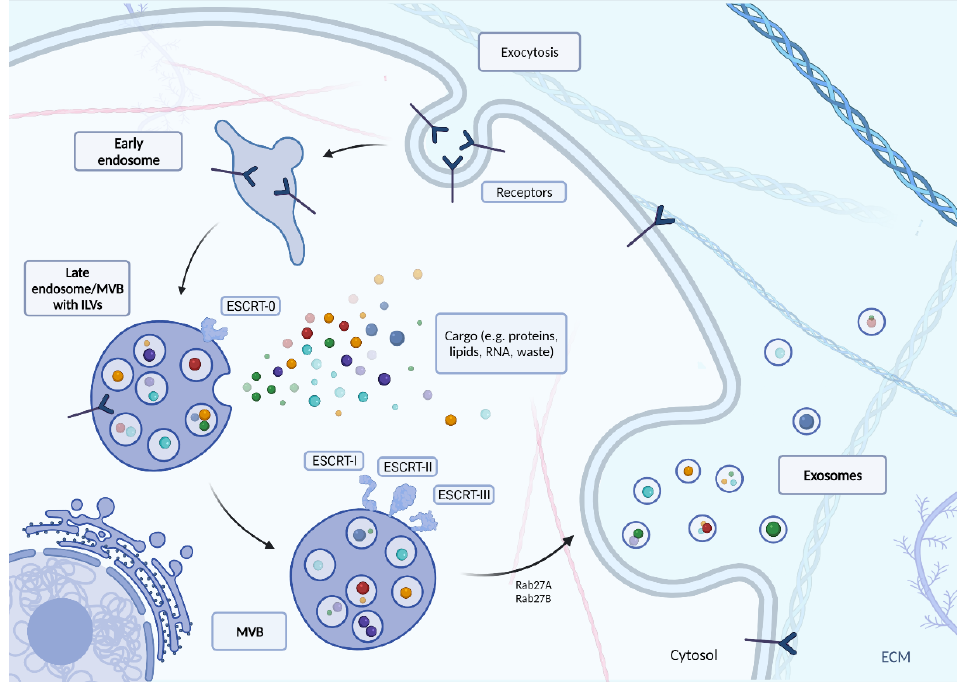
Figure 2. The biogenesis of exosomes with the use of endosomal sorting complex required for transport (ESCRT). Created with BioRender.com.